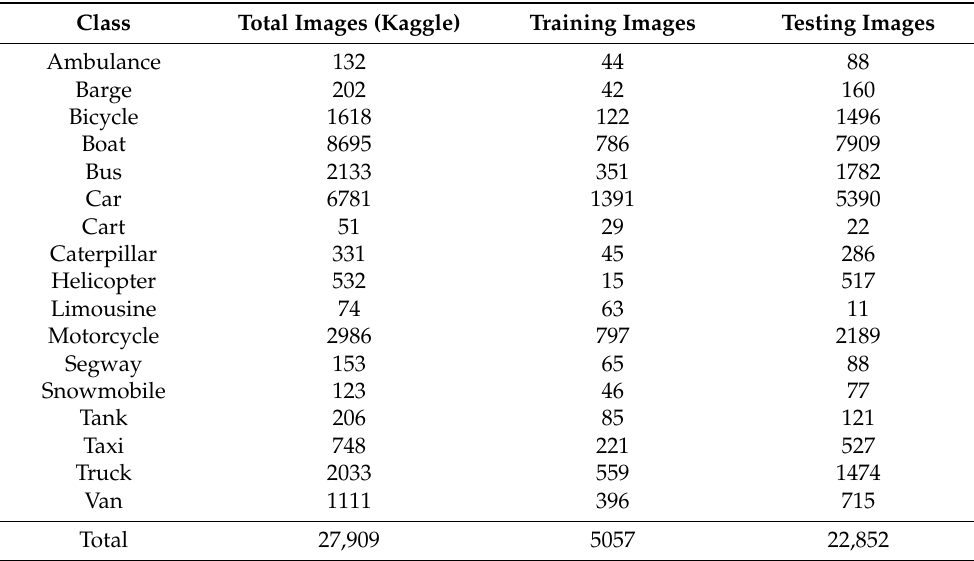
Table 2. Comprehensive overview of the Kaggle dataset.